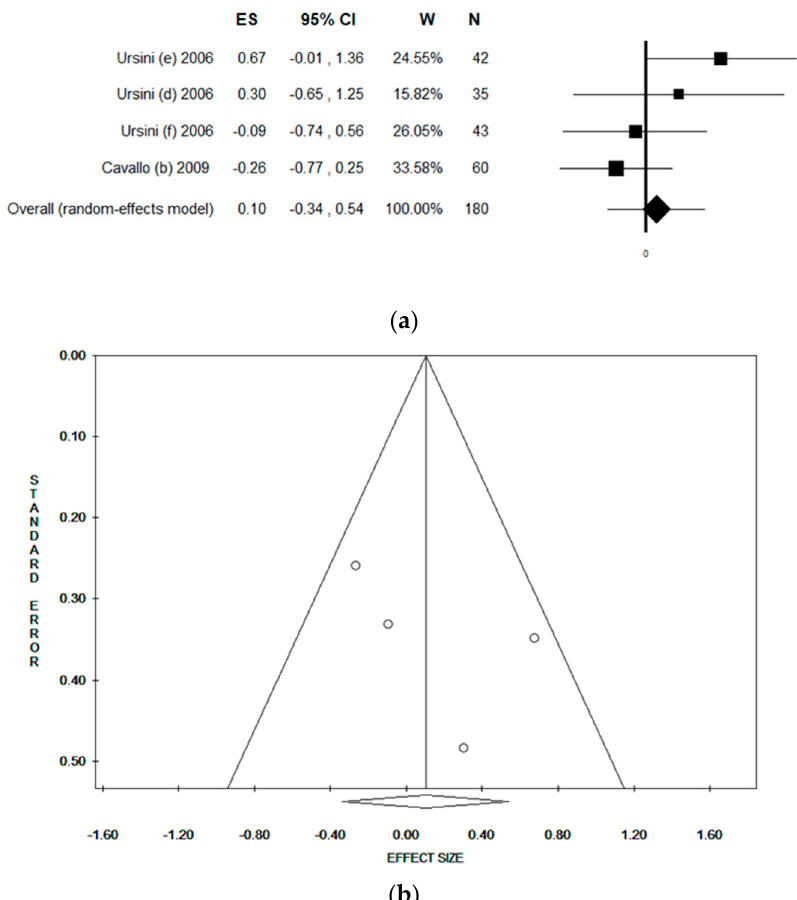
Figure 3. ( a ) Forest plot and ( b ) funnel plot of the meta-analysis assessing the comet assay on buccal cells among professionals occupationally exposed to antineoplastic drugs (ANDs).